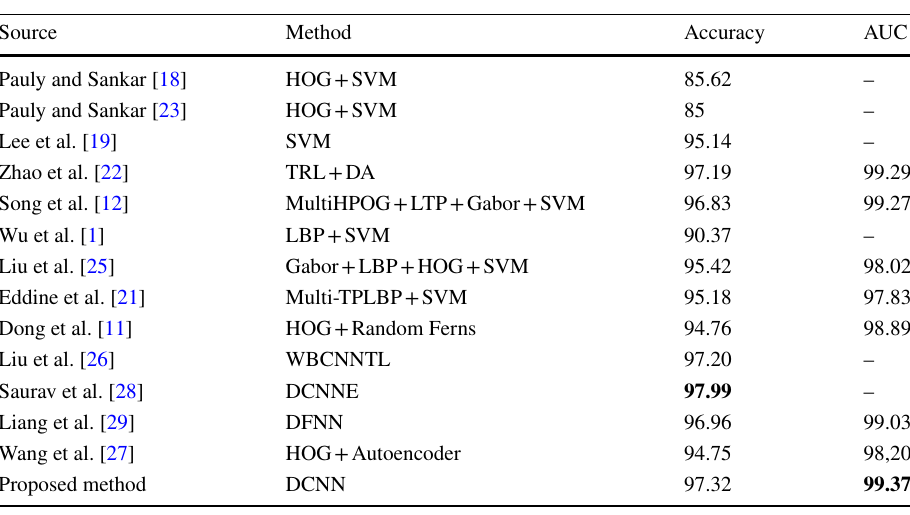
The values indicated in bold in the columns represent the